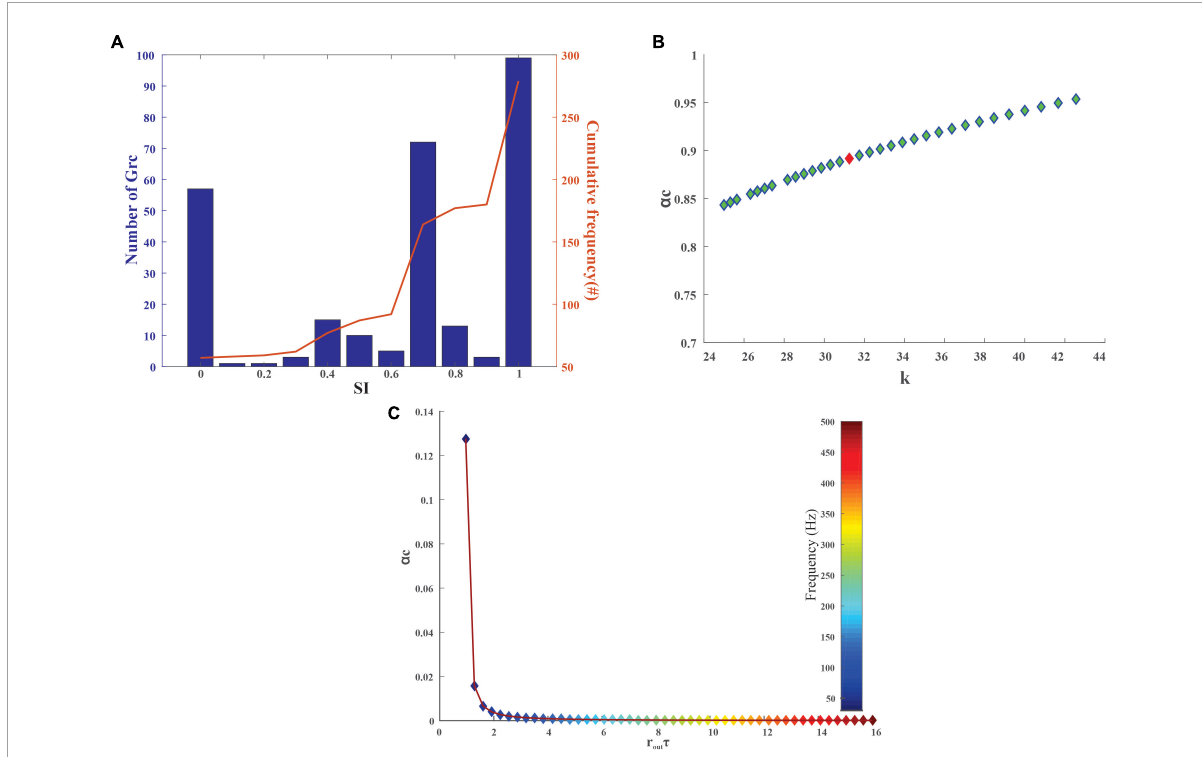
FIGURE4 Quantification of stored information in the granule layer neurons of the cerebellum-inspired model. (A) Granular layer encoding relied on connection sparseness. The sparseness index of 279 granule neurons in the network with the encoded stimuli as input was calculated after 50 epochs. As iterations increase the granule cells tend to be sparser (SI nearing 1) as seen from the cumulative frequency. (B) Storage capacity ( α c ) of granule neurons with respect to stability constant ( κ ) represents the formation and storage of new patterns. The red dot represents α c for a GrC whose membrane time constant ( τ m ) was 1.4 ± 0.12 ms. (C) Storage capacity ( α c ) of GrC with a firing frequency of 10–50 Hz was calculated and as the mean firing output spike time (r out τ ) increases, the storage capacity decreases steeply suggesting that a reduction in